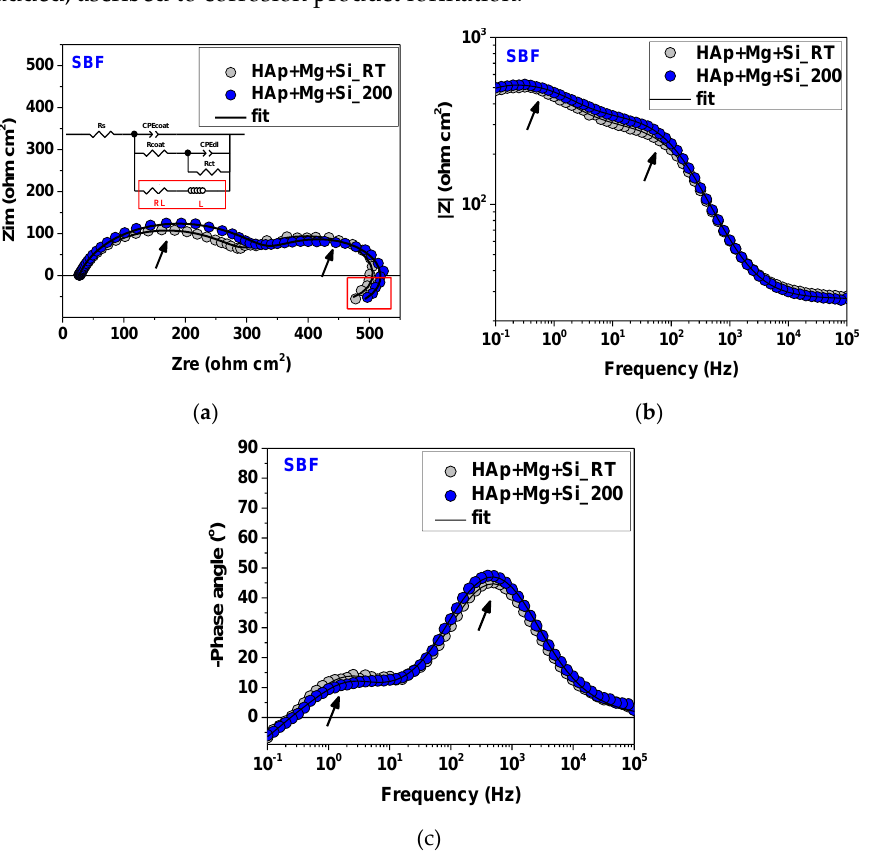
Figure 6. EIS curves of the investigated specimens immersed in SBF: ( a ) Nyquist plots, ( b ) |Z| plots, ( c ) Phase angle plots. (R s = the solution resistance, CPE coat = coating capacitance, R coat = resistance associated with the current flow, CPE dl = double layer capacitance, R ct = charge transfer resistance, L and RL were used to simulate the inductive behaviour).